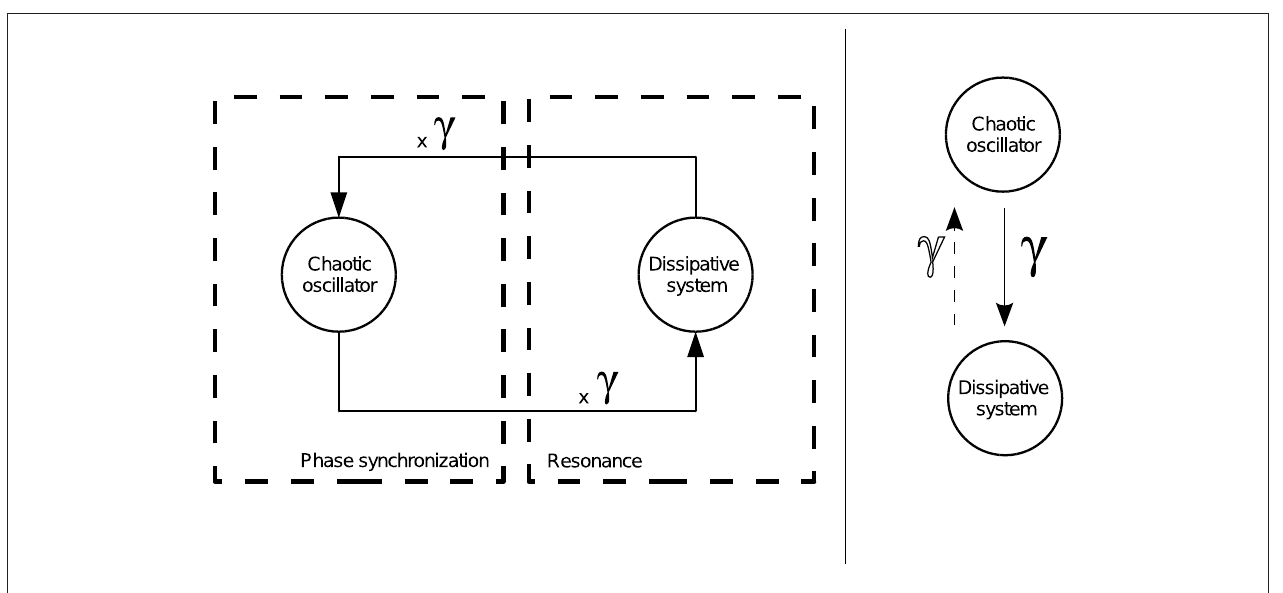
FIGURE 3 | Joint mechanism of phase synchronization and feedback resonance between an active system and a dissipative system. Depending on the values of the coupling parameter { γ }, the chaotic oscillator synchronizes or not to